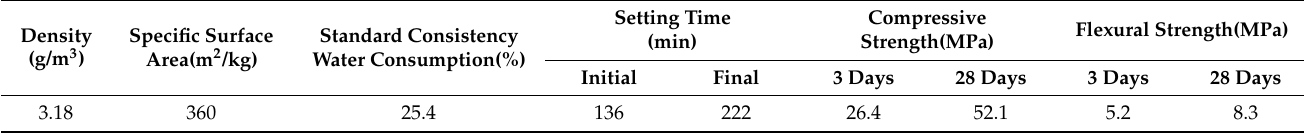
Table 2. Physical properties of cement.